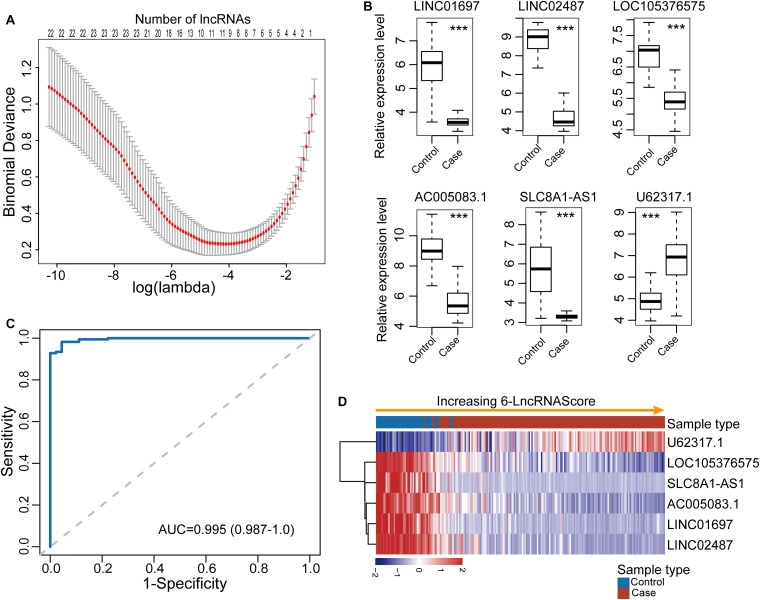
Development and performance evaluation of the lncRNA-based diagnostic risk model in the discovery dataset. (A) Feature selection for lncRNA biomarkers using the least absolute shrinkage and selection operator (LASSO) method. (B) Expression patterns of six lncRNA biomarkers between OSCC samples and control samples. (C) Receiver operating characteristic (ROC) curves for 6lncRNAScore. (D) Expression heatmap of six lncRNA biomarkers of samples with increasing 6lncRNAScore. ***p < 0.001.